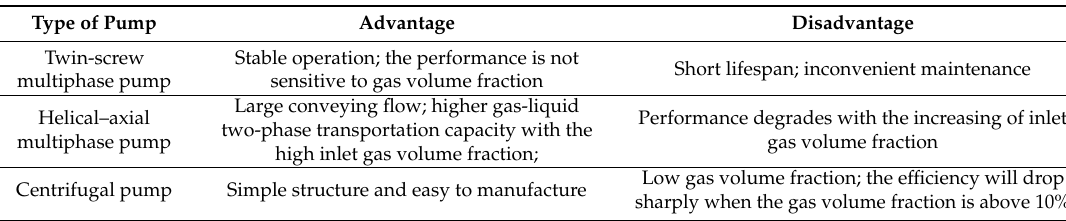
Table 1. Characteristics of di ff erent types of multiphase